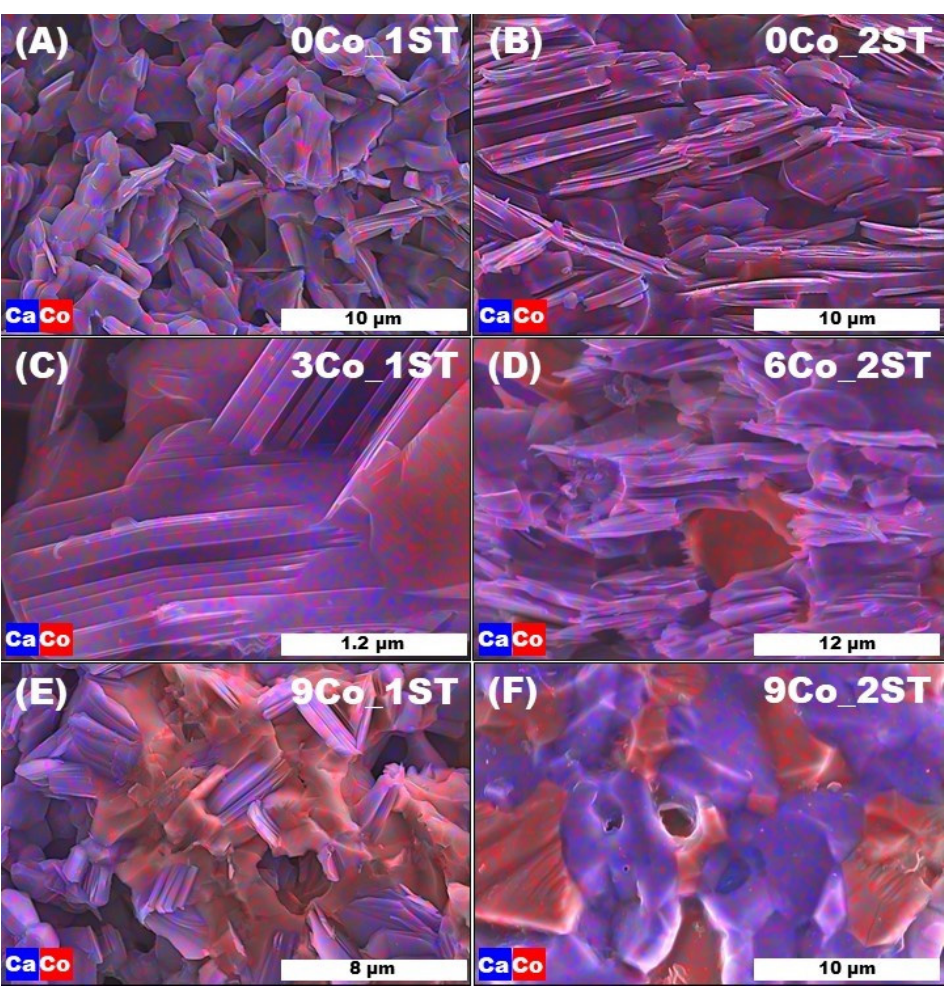
Figure 4. Representative EDS maps of fractured 1ST and 2ST sintered samples: ( A ) 0Co_1ST, ( B ) Figure4. RepresentativeEDSmapsoffractured1STand2STsinteredsamples: ( A )0Co_1ST,( B )0Co_2ST, 0Co_2ST, ( C ) 3Co_1ST, ( D ) 6Co_2ST, ( E ) 9Co_1ST and ( F ) 9Co_2ST. ( C ) 3Co_1ST, ( D ) 6Co_2ST, ( E ) 9Co_1ST and ( F )